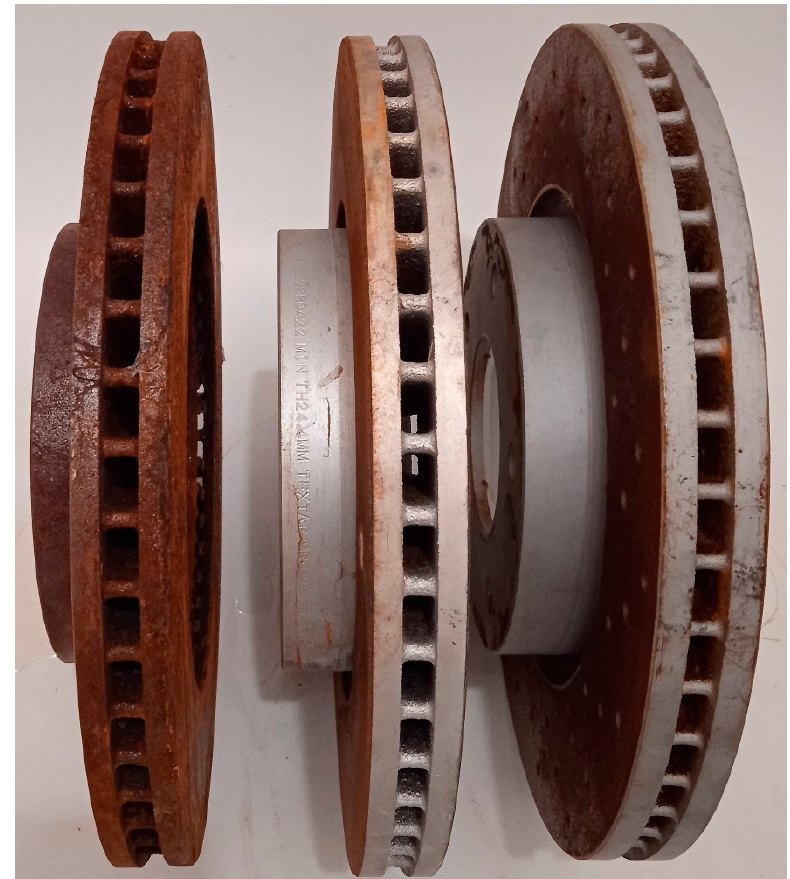
Figure 19 . Corrosion on the sides of brake discs . Figure 19. Corrosion on the sides of brake